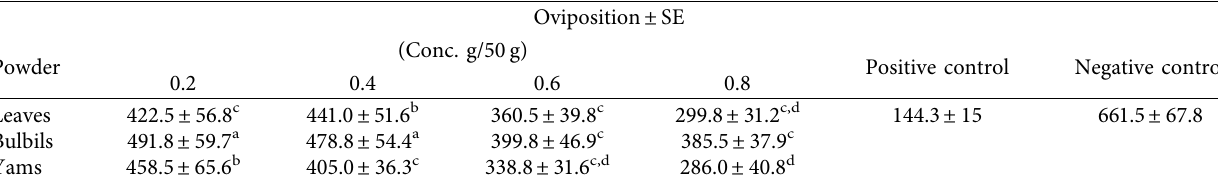
Table 2: Oviposition by Callosobruchus chinensis cultured on Phaseolus vulgaris seeds treated with powders of Dioscorea sansibarensis leaves, bulbils, and yams.